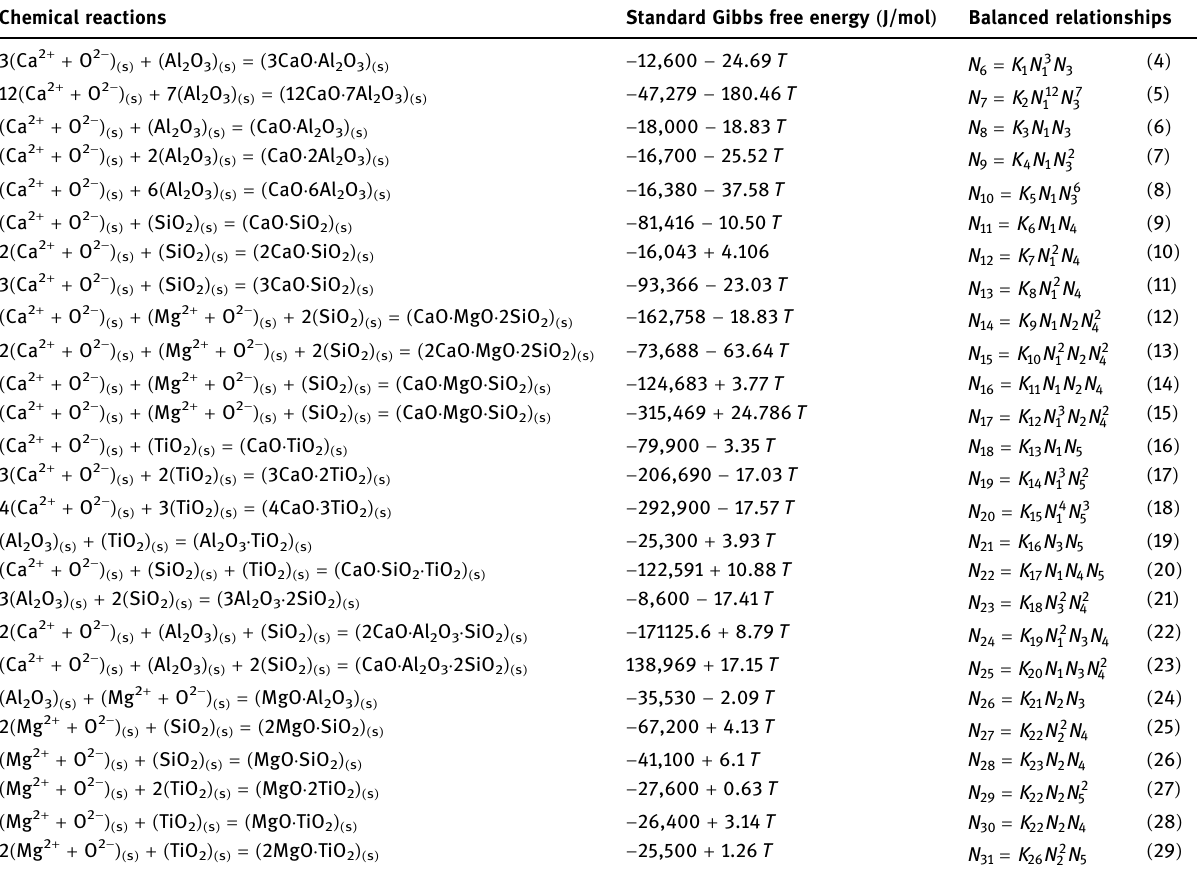
Table 1: Chemical reactions in CaO – SiO 2 – Al 2 O 3 – MgO – TiO 2 slag system Chemical